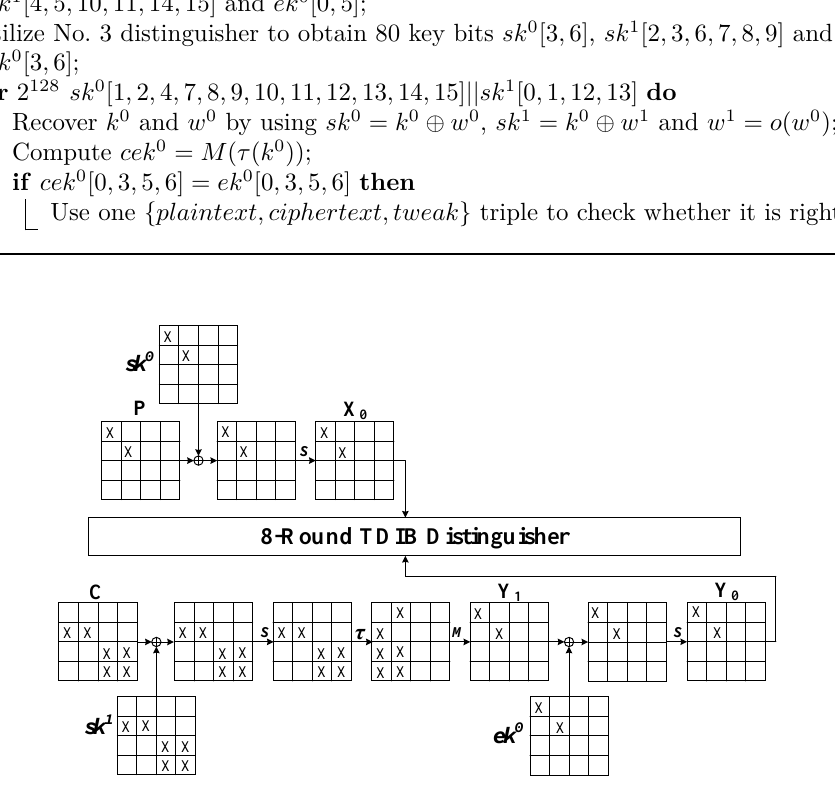
Figure 6: Key Recovery Attack on 11-Round QARMA -128 with No. 1